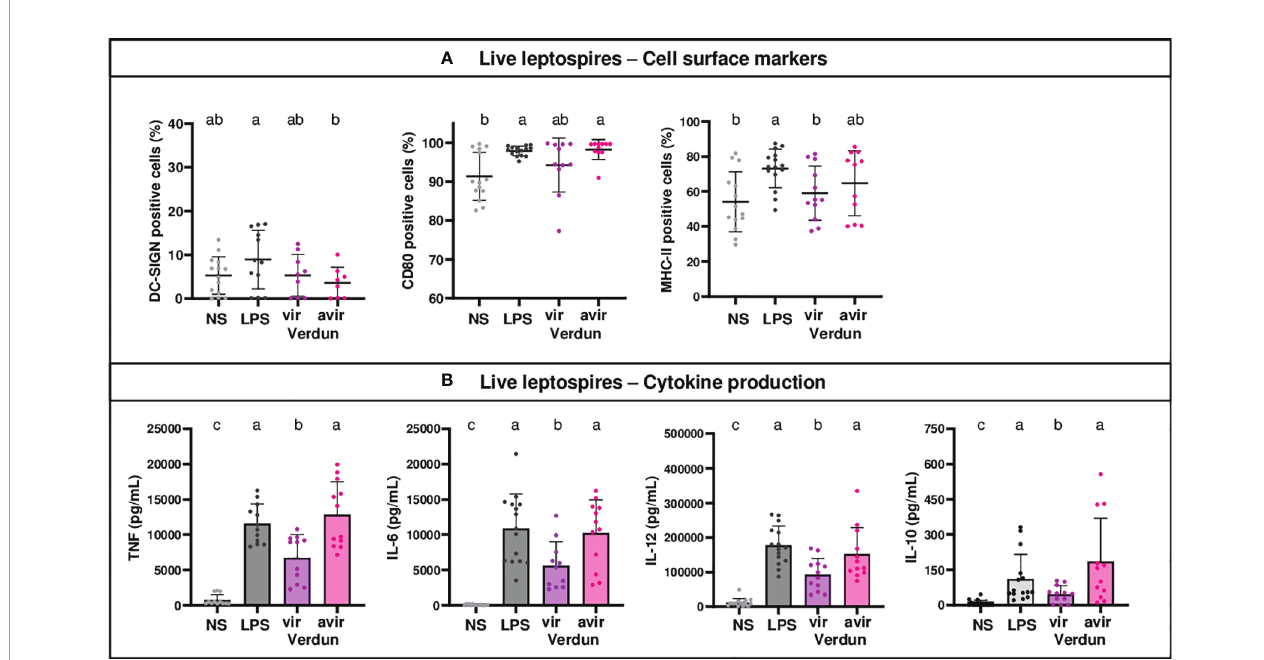
FIGURE 3 | Level of activation of OF1 BM-DCs after exposure to avirulent leptospires from the Verdun strain is higher than after exposure to virulent Verdun leptospires. Day 8 BM-DCs from OF1 mice were stimulated with live virulent and avirulent leptospires from the Icterohaemorrhagiae Verdun (Verdun vir and Verdun avir) strain at a Multiplicity of Infection (MOI) of 100 bacteria per cell. E . coli LPS (1 µg/mL) was used as a positive control for DCs stimulation. After 24h, cells were immunostained for the analysis of the expression of cell surface markers (A) through fl ow cytometry and cytokine concentrations (B) were also quanti fi ed in cell supernatants by ELISA assays. Data were compared to results with non-stimulated cells (NS). A: Dot plot diagrams show the percentage of BM-DCs positive for DC-SIGN, CD80 and MHC-II staining. (B) Histograms with dot plot show the concentration of pro-in fl ammatory TNF, IL-6 and IL-12p40 and anti-in fl ammatory IL-10 cytokines in cell supernatants. Each dot represents one out of three stimulation replicates from three independent experiments with n=3 mice. Mean ± SD is represented. For each marker or cytokines, statistics indicated with lower-case letters allow for comparing all conditions. Conditions that share the same lower-case letters are not signi fi cantly different (p > 0.05). In contrast, conditions that do not share same letter(s) are signi fi cantly